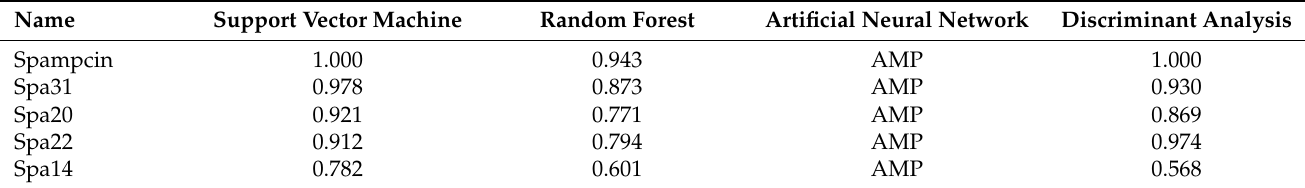
Table 1. AMP probability of four synthetic peptides by CAMP R3